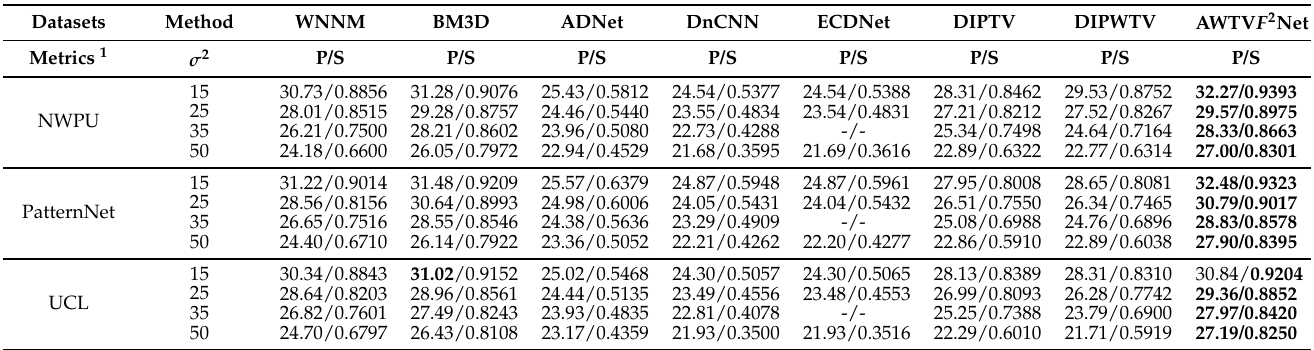
Table 1. Comparison results of different methods with four noise levels on the three datasets. The bold values denote the best